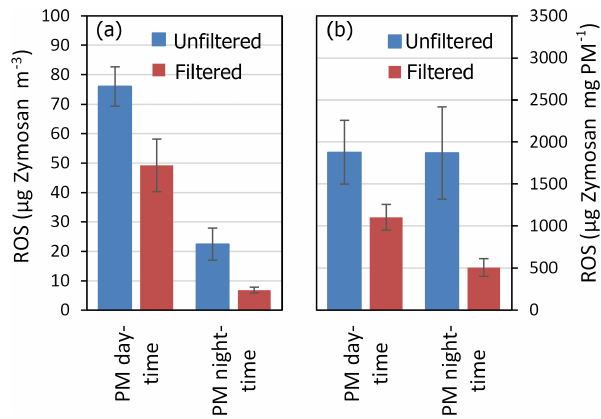
Figure 2. Per-volume (µgzymosanm − 3 air) (a) and per-mass (µgzymosanmgPM) (b) ROS activity of the aerosol samples col- lected in the Po Valley in fall 2015. The values for aerosol samples are based on both filtered (representing the redox activity of WS components) and unfiltered (representing the redox activity of both WS and WI components) ROS analysis protocols. Bars represent geometric means and error bars correspond to 1 standard error